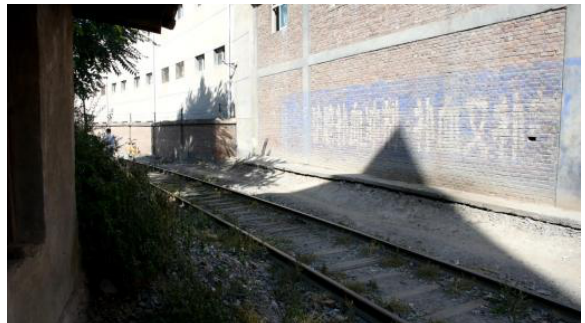
Fig. 15. The original image of the 630 th frame of video 3